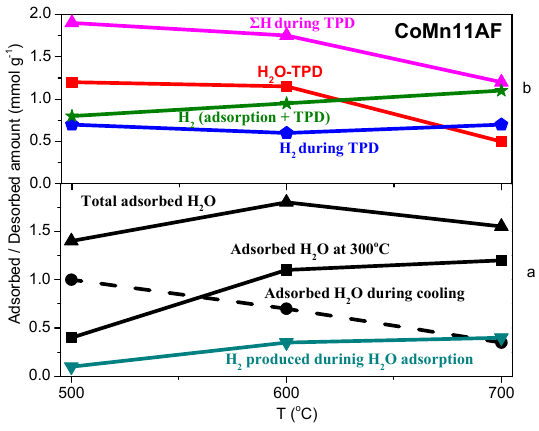
Figure 7. ( a ) Total adsorbed Η 2 Ο at 300 °C and Η 2 produced during water adsorption; and ( b ) H 2 O desorbed and H 2 produced during TPD. CoMn11AFp i with i = 500, 600, 700 °C. desorbed and H 2 producing during TPD. CoMn11AFp i with i = 500, 600, 700 ˝ C.